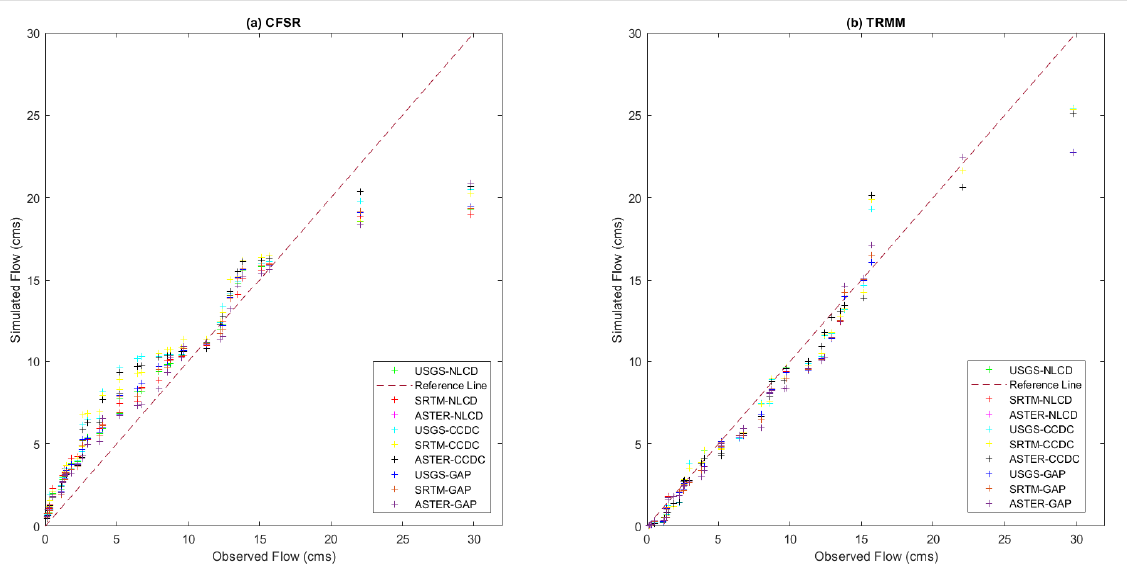
Figure 16. Variation of simulated flows with observed flows was obtained for the two precipitation datasets: ( a ) CFSR and ( b ) TRMM, with nine different combinations for the South Fork watershed.